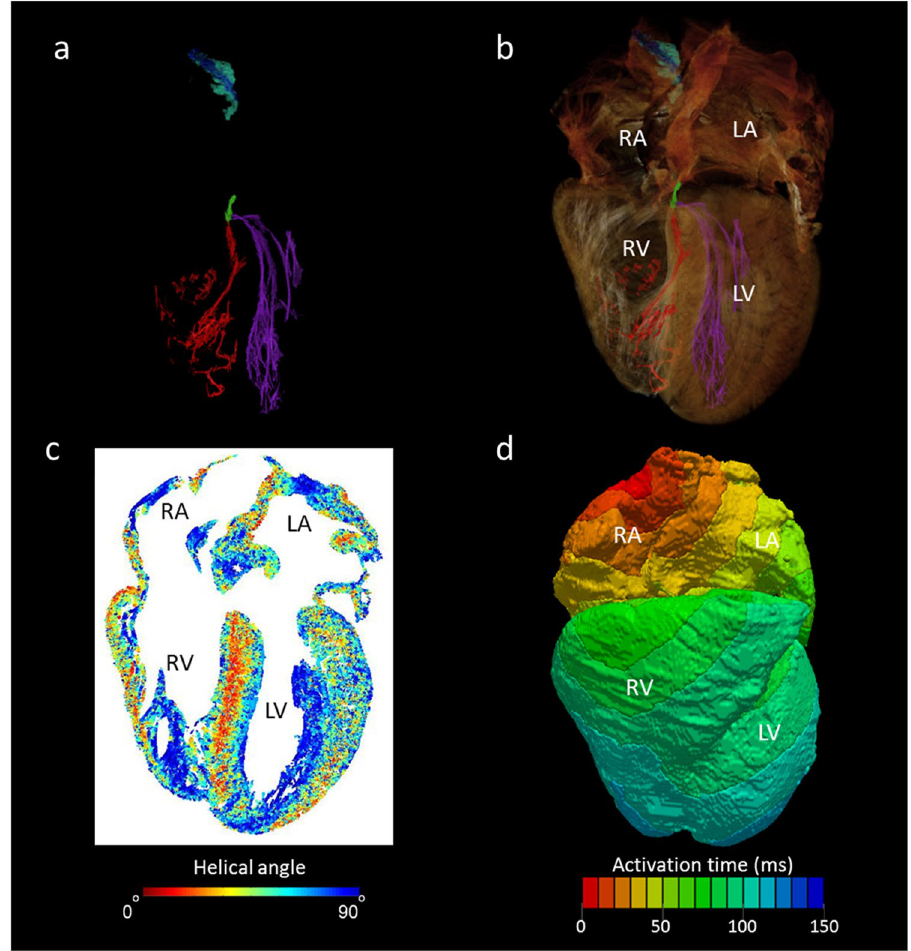
Figure 7. The utility of whole heart micro-CT data in mathematical modelling of cardiac depolarisation. Panel (a) shows the conducting tissue segmented from human whole heart micro-CT dataset; sinus node (blue), paranodal area (turquoise), atrioventricular conduction axis (green), the right (red) and left (purple) Purkinje networks. Panel (b) places the segmented conduction system in the anatomical context of the surrounding myocardium. Panel (c) shows a four-chamber view of cardiomyocyte orientation in which the absolute helical angles derived from the CT dataset are coded in colour (see colour map). Panel (d) is an illustrative isochrone map of cardiac depolarisation seeded from the sinus node. The model incorporates the anatomically accurate geometry of the myocardium and the accurate disposition of the conduction system with the electrical properties of these various regions derived from published electrophysiological measurements. IAS- interatrial septum, IVS- interventricular septum, LA- left atrium, LV- left ventricle, RA- right atrium, RV- right